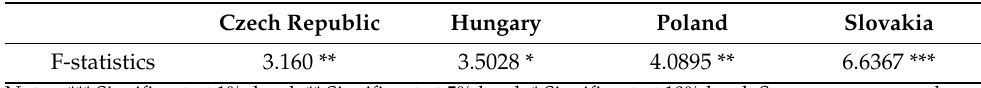
Table 3. F-statistics for cointegration relationship for import